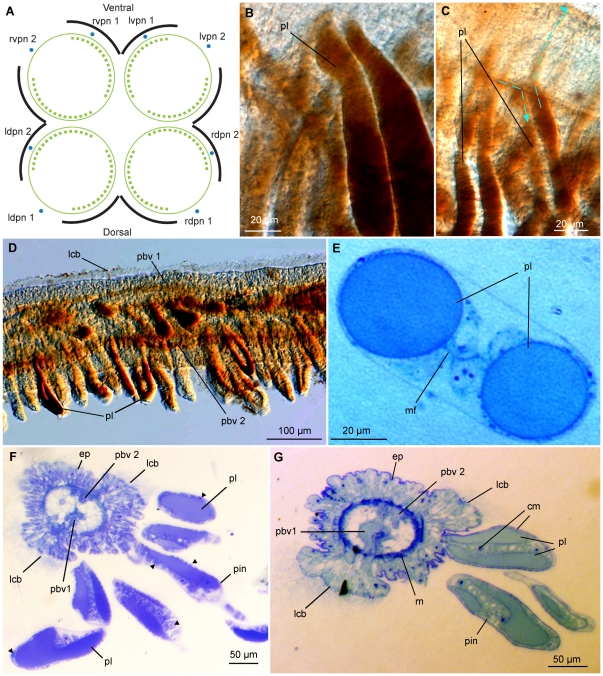
Diagram of a transverse section of the basal part of palps (A), DIC light micrographs of benzidine stained palps (B–D) and transverse 1.2 µm sections of O. mucofloris palps stained with toluidine blue (E–G).A: Diagram of a transverse section at the basal part of the palp region. Circular musculature (continued green lines) encircles the longitudinal musculature (green broken lines) in a cylinder formation. Two gaps separate the longitudinal muscle bands. Black lines illustrate the motile lateral ciliary bands and two main palp nerves run along each palp as shown (blue dots). B: Pinnular loop filled with blood. C: Pinnular loops, broken lines and arrows indicate the assumed direction of blood flow. D: Midsection of palp, longitudinal blood vessels and pinnular loops visible. E: Transverse section of a pinnule, the pinnular loop enclosed by a membrane fusing in the centre. F: Transverse section of the distal part of a palp, arrow tips shows circular musculature. G: transverse section of the distal part of a palp, the two longitudinal blood vessels obvious. Abbreviations: circular muscles (cm), epidermis (ep), lateral ciliary band (lcb), left dorsal palp nerve (ldpn), left ventral palp nerve (lvpn), membrane fusion (mf), musculature (m), palp blood vessel (pbv), pinnule (pin), pinnular loop (pl), right dorsal palp nerve (rdpn), right ventral palp nerve (rvpn).